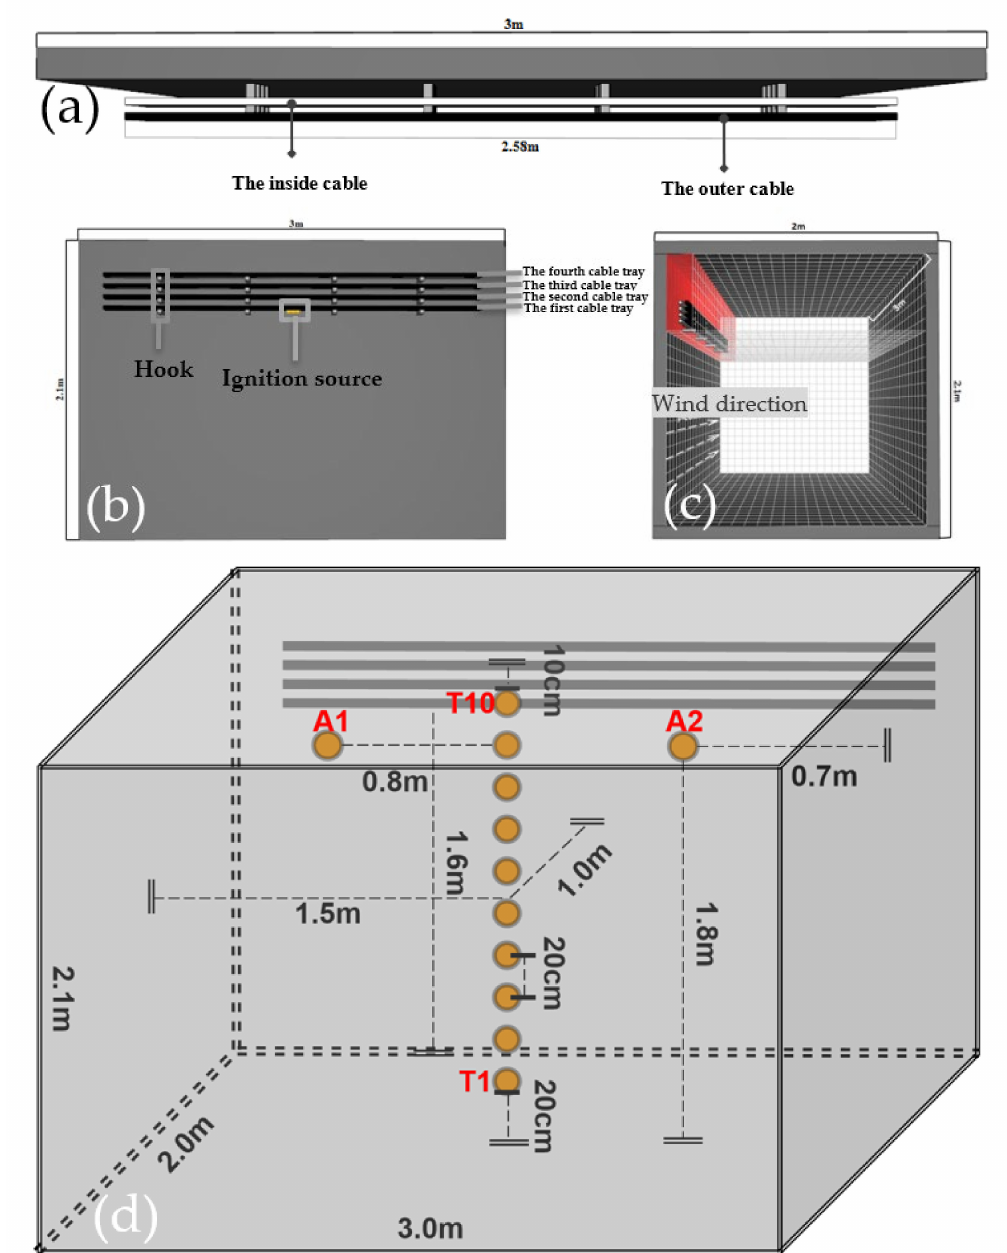
Figure 1. Diagram of mine tunnel and meshes: ( a ) Top view of the side where the cable is placed; ( b ) Front view of the side where the cable is placed; ( c ) Dividing Mesh; ( d ) Diagram of thermocouple